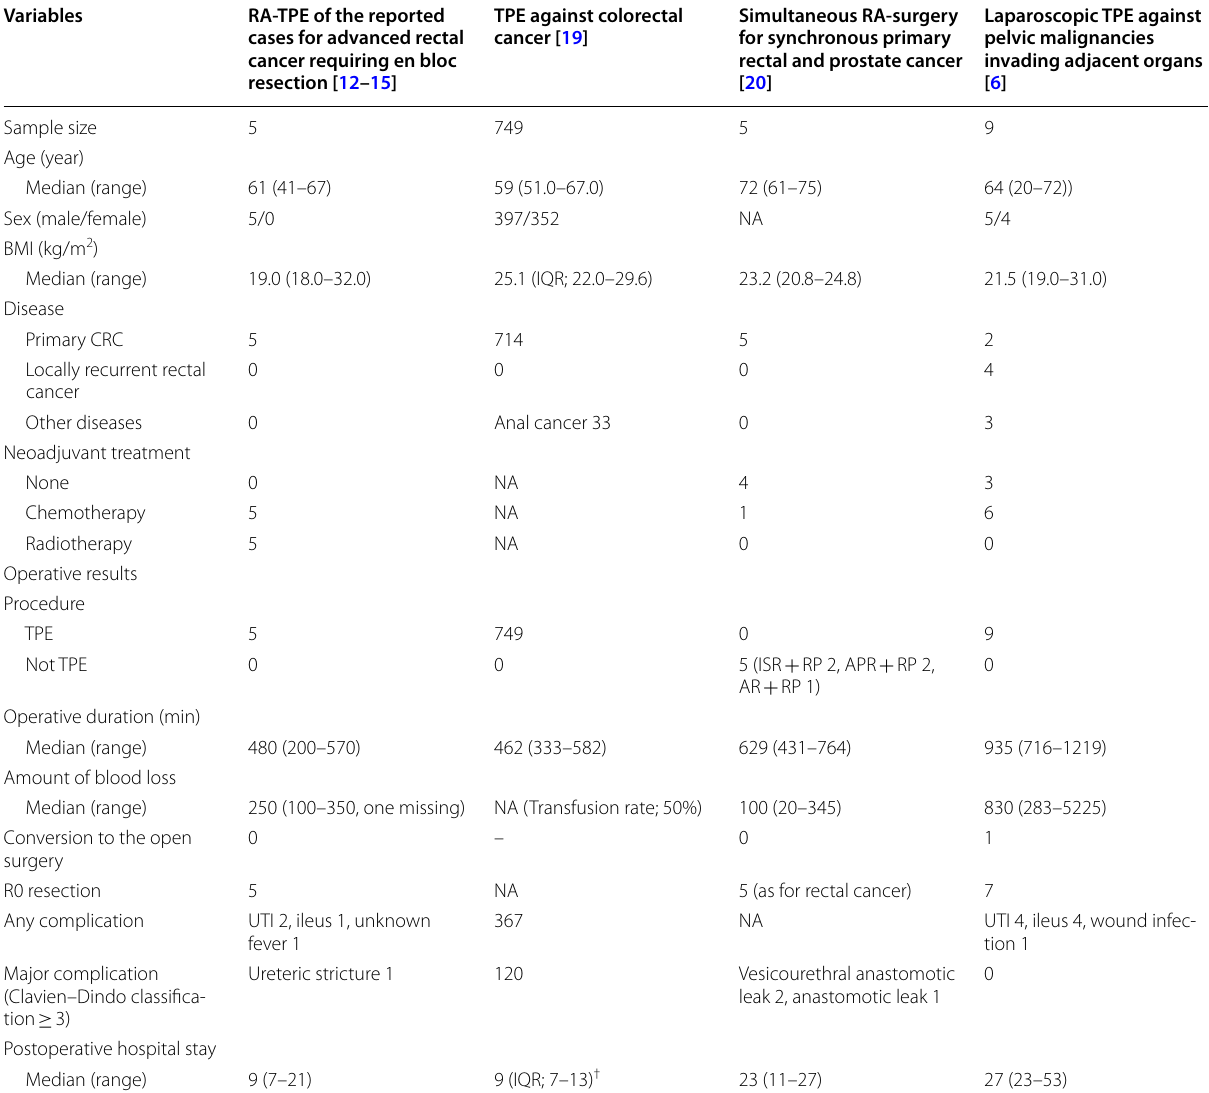
Table 2 Comparison of the outcomes between the reported RA-TPE cases and the other approaches for multivisceral exenteration